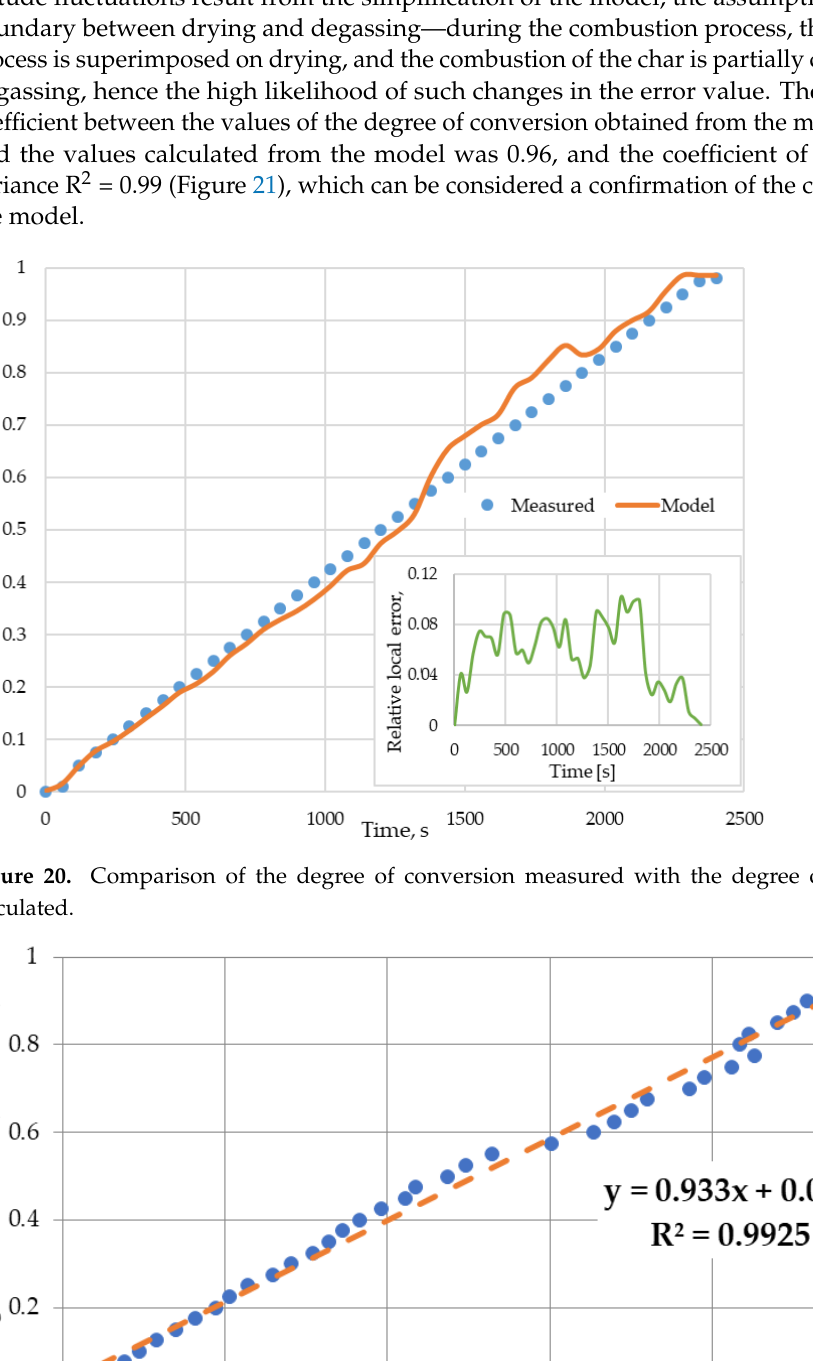
Figure 19. Correlation of measured and calculated temperature.